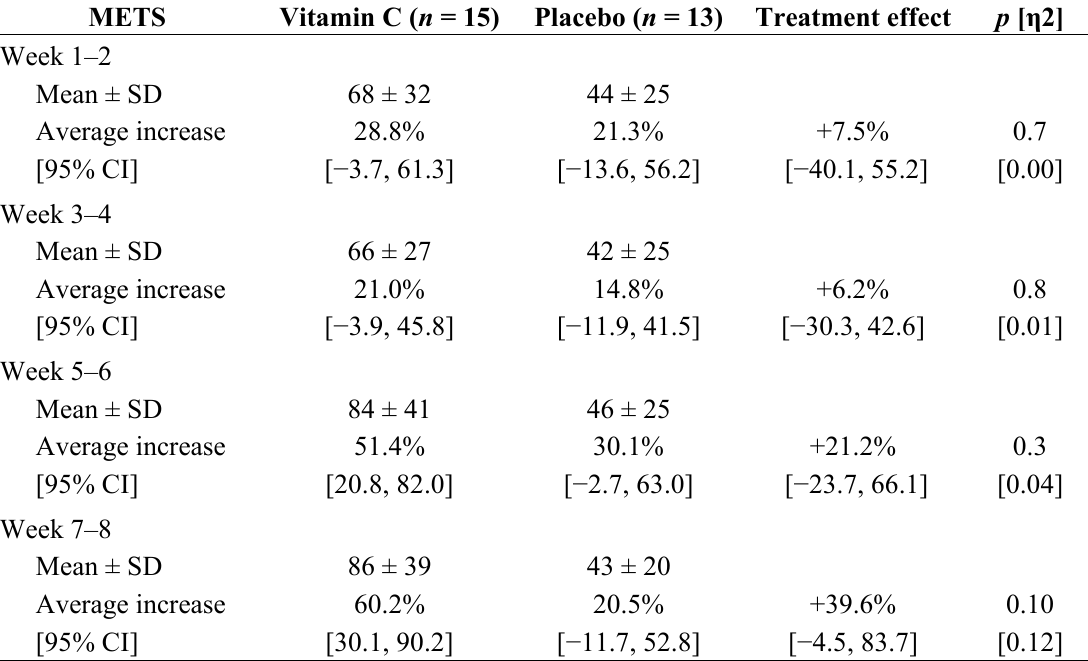
Table 2. The energy cost of activities, or metabolic equivalents (METS; kcal·kg − 1 ·week − 1 ) in participants ingesting vitamin C (1000 mg) or placebo daily for eight weeks. The data are averaged at two-week intervals and presented as the mean value; the percent increase from baseline with 95% CI; and the treatment effect